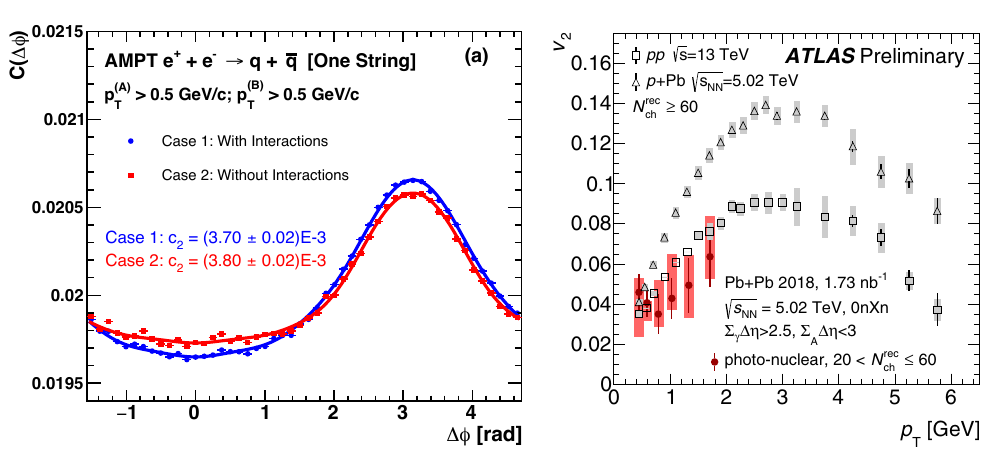
q ¯ q events with a single string →